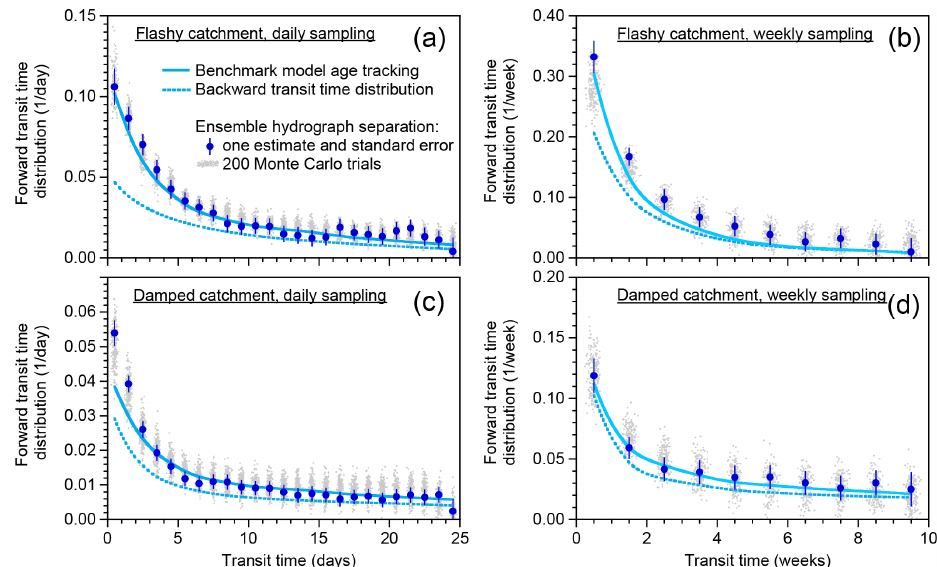
Figure 14. Forward transit time distributions (the fraction of precipitation that leaves the catchment within one time step, two time steps, and so on) estimated by ensemble hydrograph separation (Eq. 63) compared to benchmark model age tracking. Panels (a, b) and (c, d) show TTDs for flashy and damped catchments, respectively; the model is driven by Smith River (Mediterranean climate) precipitation in both cases. Ensemble hydrograph separation estimates from tracer fluctuations (dark blue symbols) are broadly consistent with true TTDs from age tracking in the benchmark model (solid curve). Data clouds show ensemble hydrograph separation results (slightly jittered on the horizontal axis) from 200 different realizations of random precipitation tracer values, random missing data, and random measurement errors. Dashed curve is the benchmark model backward TTD from Fig. 11 for